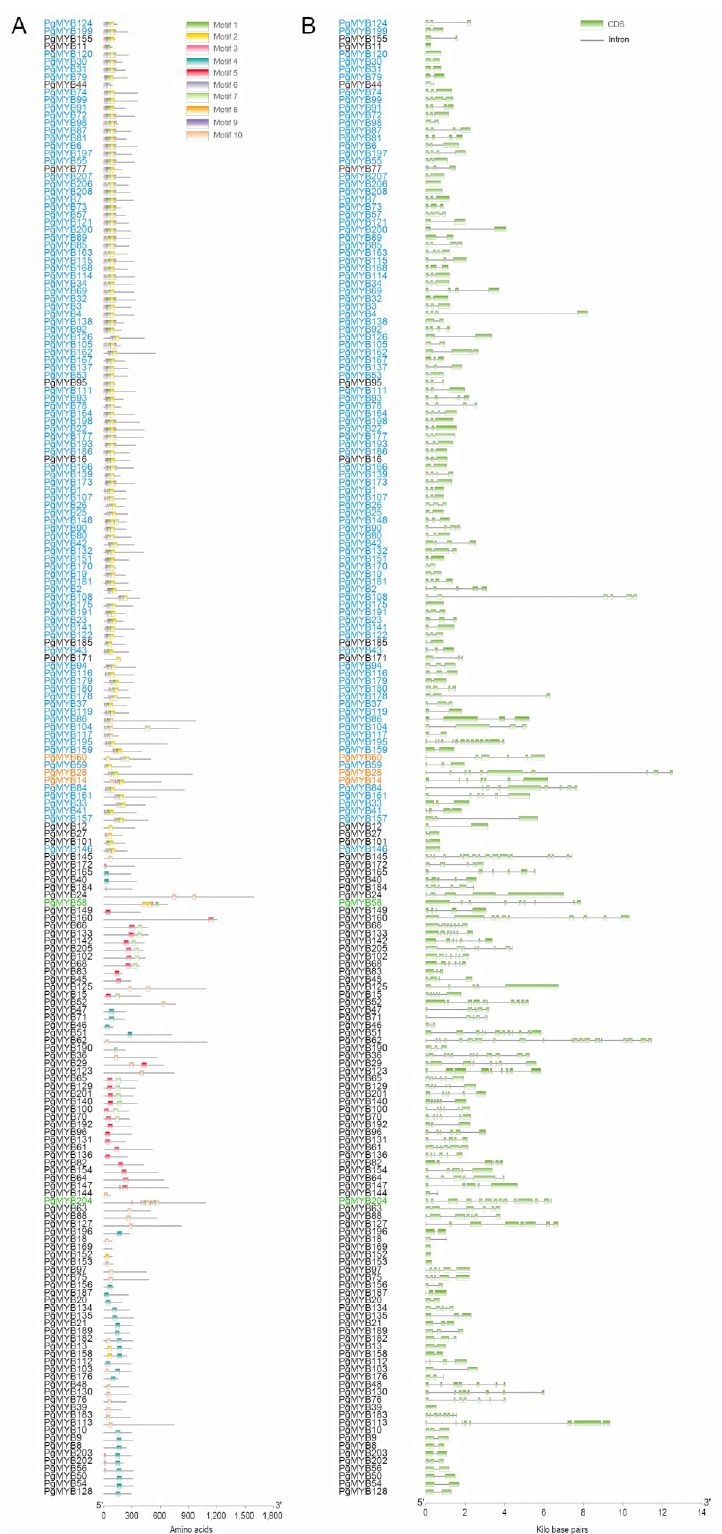
Figure 2. Distribution of conserved motifs and gene structural analysis of PgMYB gene family. ( A ) The conserved motifs of PgMYB proteins were predicted by MEME Suite 5.4.1 and visualized using TBtool. ( B ) Exon–intron distribution of PgMYB genes. Exons and introns are represented by green rectangle boxes and black lines, respectively. Members belong to MYB-R2R3, MYB-related, and MYB-3R, and atypical subfamilies are represented in blue, black, orange, and green fonts,